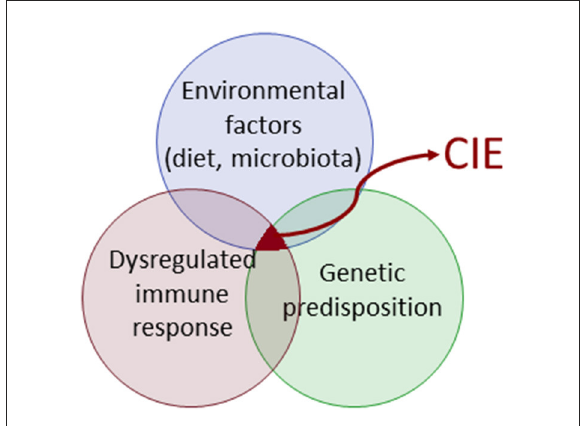
FIGURE1 Complex disease pathogenesis in canine chronic inflammatory enteropathy